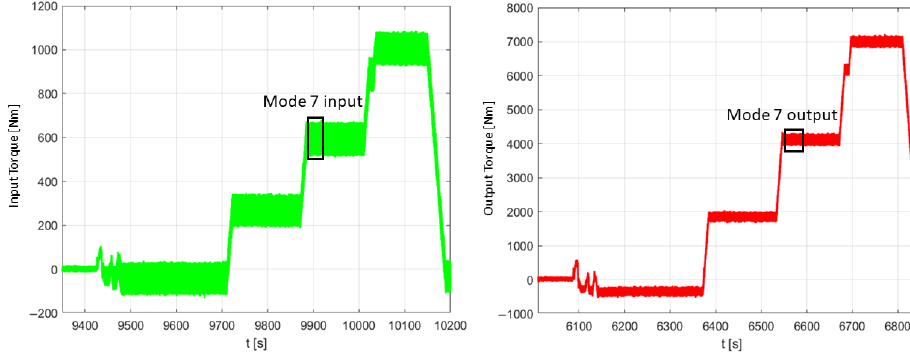
Figure 9. The example of recorded data—input torque ( left ), output torque ( right